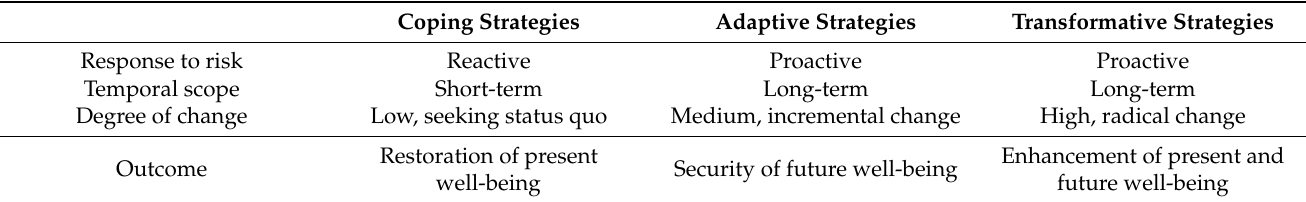
Table 1. The matrix of social resilience, after Keck and Sakdapolrak [21] (p. 10). Coping Strategies Adaptive Strategies Transformative Strategies Response to risk Reactive Proactive